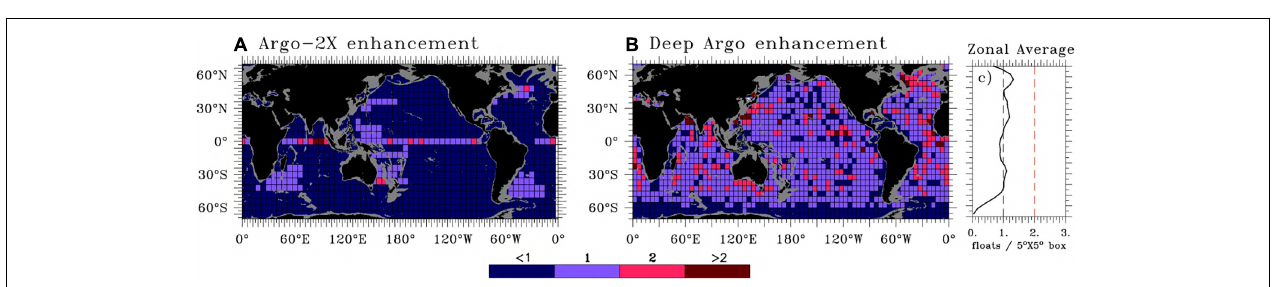
FIGURE 2 | Synthetic Argo enhancements for the (A) Argo-2x and (B) Argo-deep designs additionally to the Backbone Argo design ( Argo-1x ). The number of floats is calculated for the upper-ocean (0–2000 m) in Argo-2x per 6 ◦ × 6 ◦ box, and for the deeper ocean (below 2000 m) in Argo-deep per 5 ◦ × 5 ◦ box. In (C) , the zonally averaged number of floats of the Argo-deep design is indicated for the global Ocean. Note that unit in (A) is equivalent float number per 3 ◦ × 3 ◦